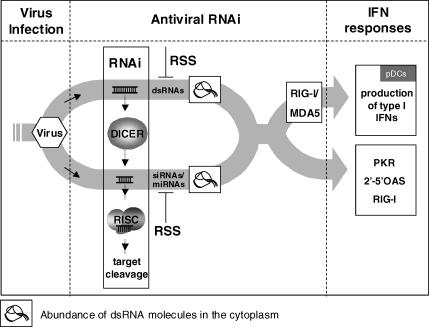
Antiviral RNAi Activity and IFN Responses Function together in Innate Antiviral DefencesDuring virus replication, virus-specific dsRNA molecules are generated that are recognized by Dicer and processed into siRNAs. One strand of the siRNA, the guide-strand, is loaded into RISC, which targets viral RNAs for destruction. To escape this antiviral pressure, viruses encode RSS factors that block the RNAi pathway. When virus-specific dsRNA molecules and siRNAs accumulate above a certain threshold, and consequently can no longer be masked by the viral RSS, the cytoplasmatic dsRNA sensors RIG-I/MDA5, PKR, and 2′5′ OAS/RNAseL are activated. This results in the activation of range antiviral responses, including the production of type I IFNs, general translational inhibition, and RNA degradation. This model clarifies why RSSs like NS1, VP35, and E3L have been identified as IFN antagonists.